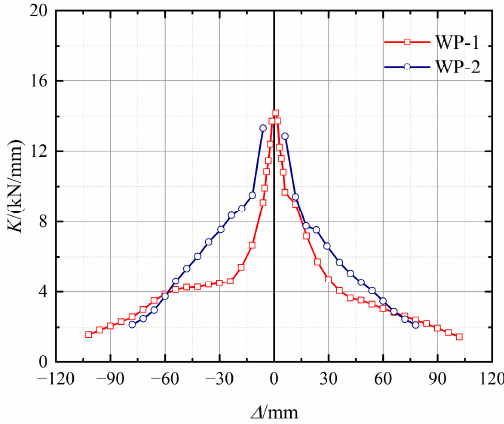
Figure 14. The rigidity degradation.